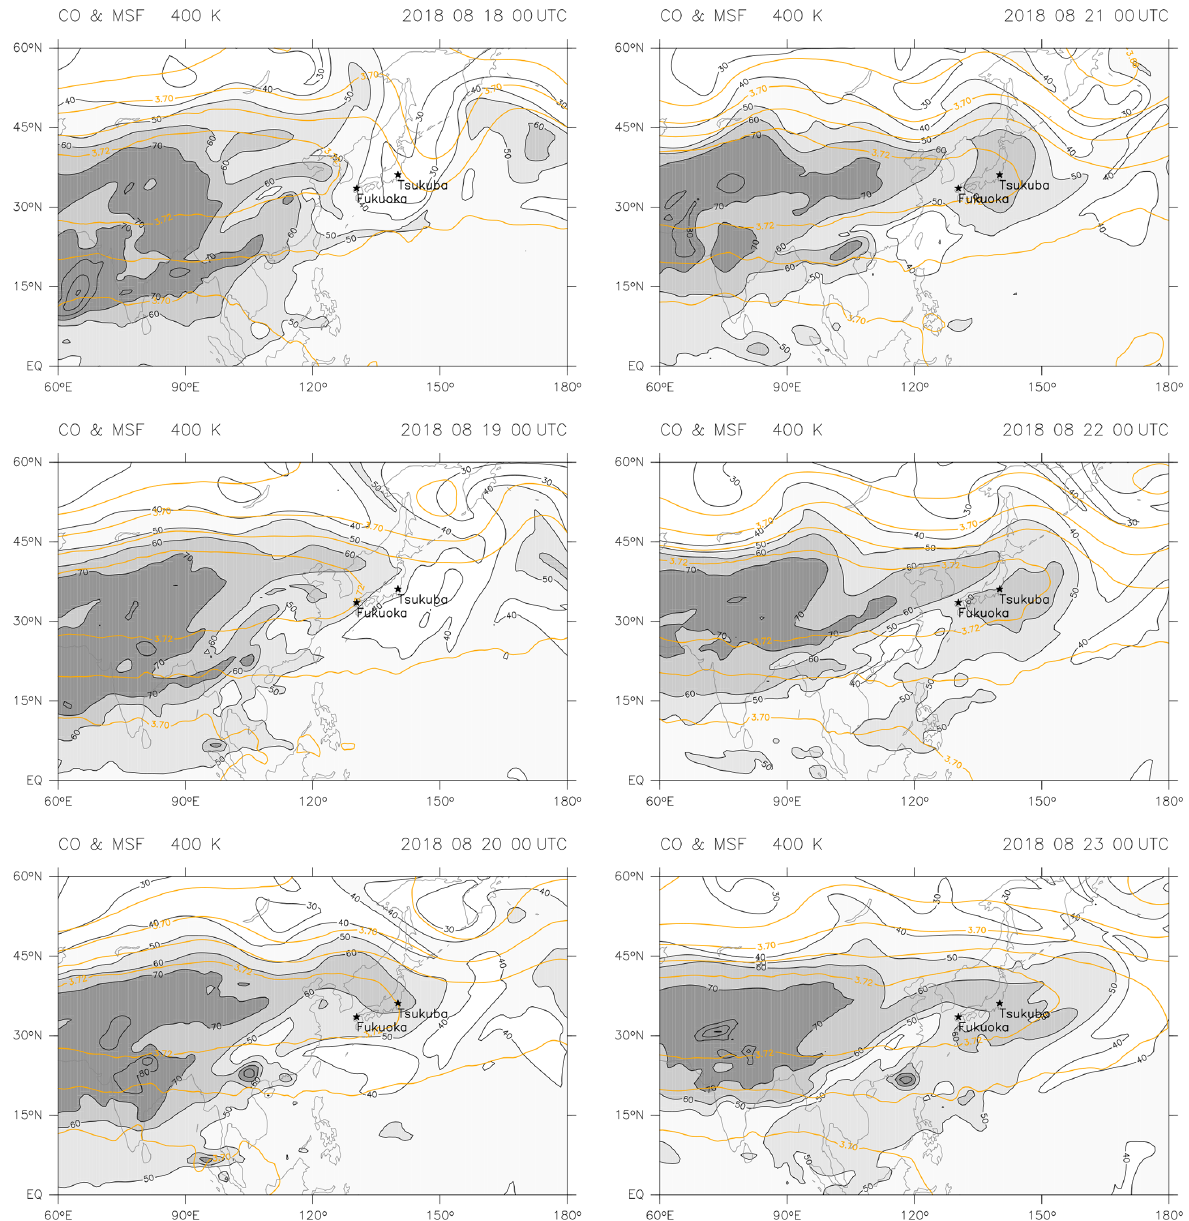
Figure 6. Horizontal distribution of daily instantaneous (00:00UTC) CO (black contours with grey tone, with intervals of 10ppbv) and the Montgomery streamfunction (MSF; coloured contours at intervals of 0.01 × 10 5 m 2 s − 2 ) at the 400K potential temperature level during 18–23 August 2018 (dates indicated at the top right of each plot) using CAMS reanalysis